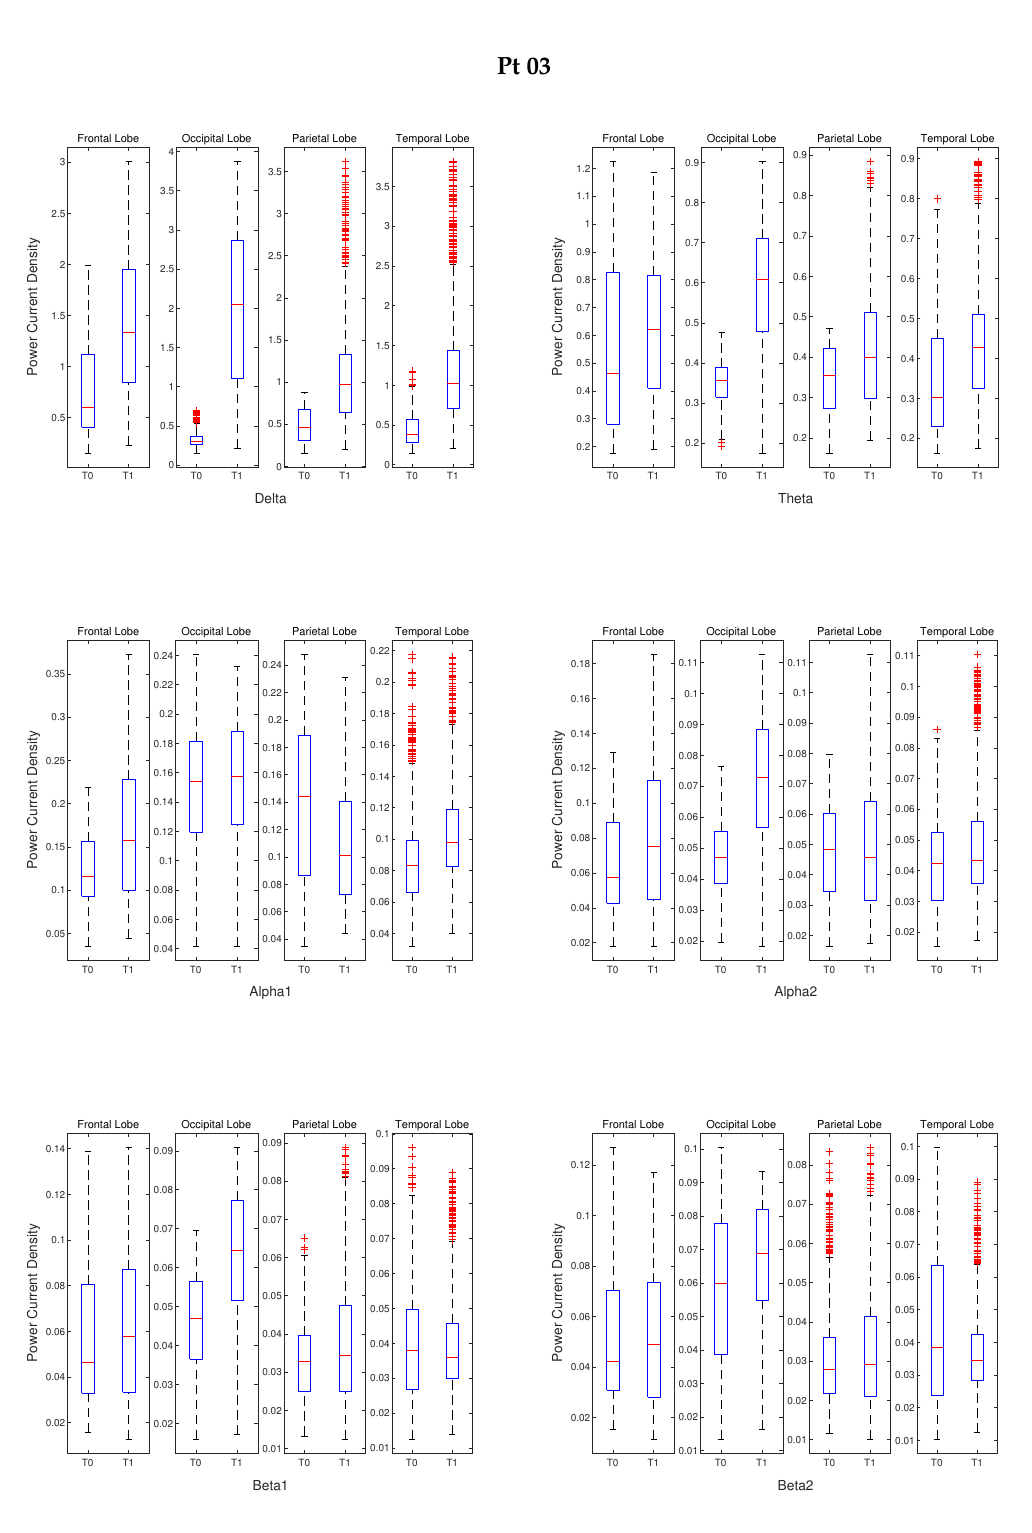
Figure 2. Boxplot of the power current density of patient 03 at time T0 and T1 for each frequency sub-band and each region of interest (frontal, occipital, parietal, and